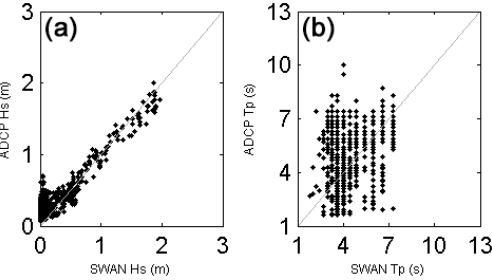
Figure 11. SWAN vs. ADCP scatter plots of H s (a) and T p (b) in Playa de Palma.